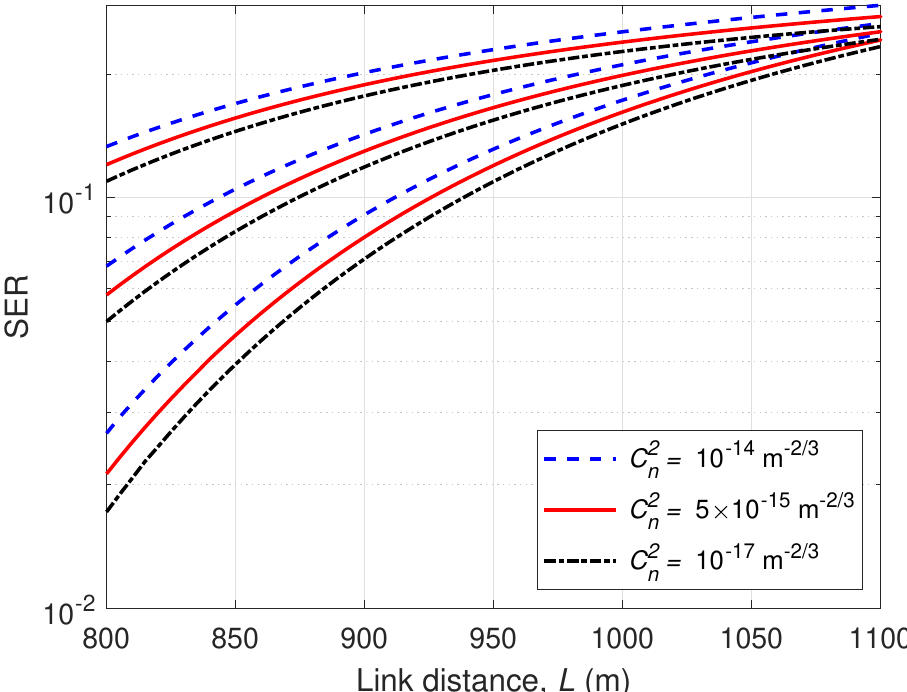
Figure 7. SER versus link distance, L , for different values of turbulence strength, various values of the pointing error displacement standard deviation σ s = 0.05, 0.07, and 0.1 (from bottom to top) with the optimal beam waist radius.